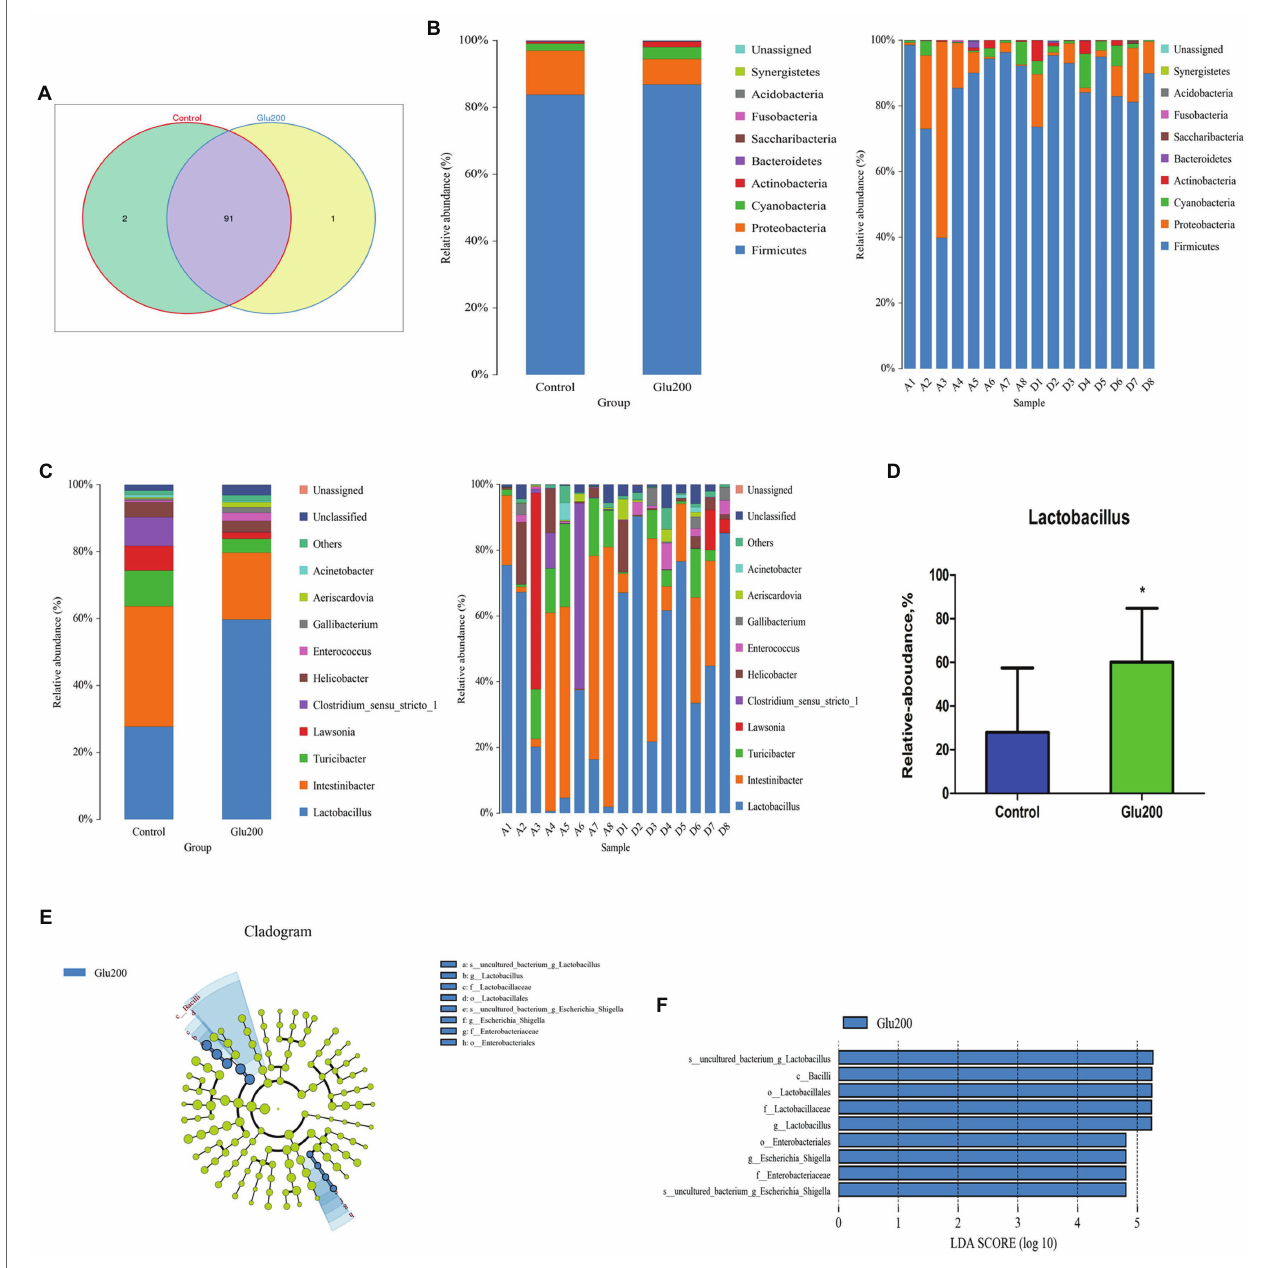
FIGURE 2 | Changes of microbial composition in the ileum of breeder laying hens fed with or without dietary Glu200. (A) Venn diagram for bacterial OTU compositions in two groups. (B) Microbial composition at the phylum level. (C) Microbial composition at the genus level; each bar represented the average relative abundance of each bacterial taxon within a group. (D) Difference of the relative abundances of Lactobacillus between Control and Glu200 groups. LEfSe was used to explore differences between Control and Glu200 groups. (E) Cladogram plot of LEfSe analysis. (F) Histogram of LDA value distribution between Control and Glu200 groups. *means significant difference between